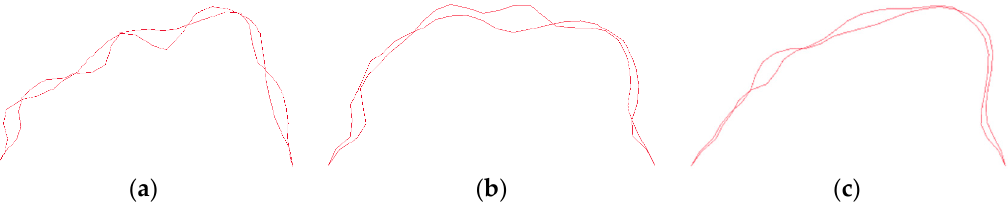
Figure 13. The displacement mode when t = 0.24 s, t = 0.60 s, t = 1.26 s, P23. ( a ) t = 0.24 s, ( b ) t = 0.60 s, and ( c ) t = 1.26 s.